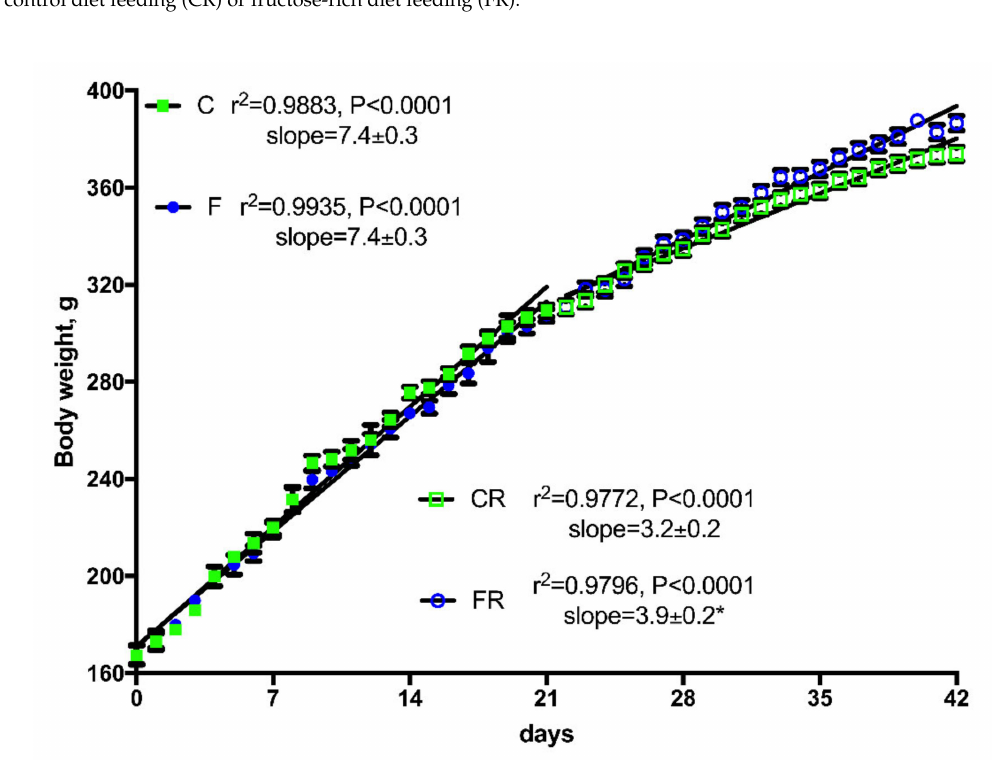
Figure 2. Body weight gain in control (C), fructose (F), control rescue (CR), and fructose rescue (FR) rats. Values are the means ± SEM of 16 (C and F) or eight (CR and FR) different rats. Linear regression analysis showed that line for FR rats was significantly different ( p < 0.05) from line for CR rats. * Slope from FR rats was significantly higher ( p < 0.05) than that from CR